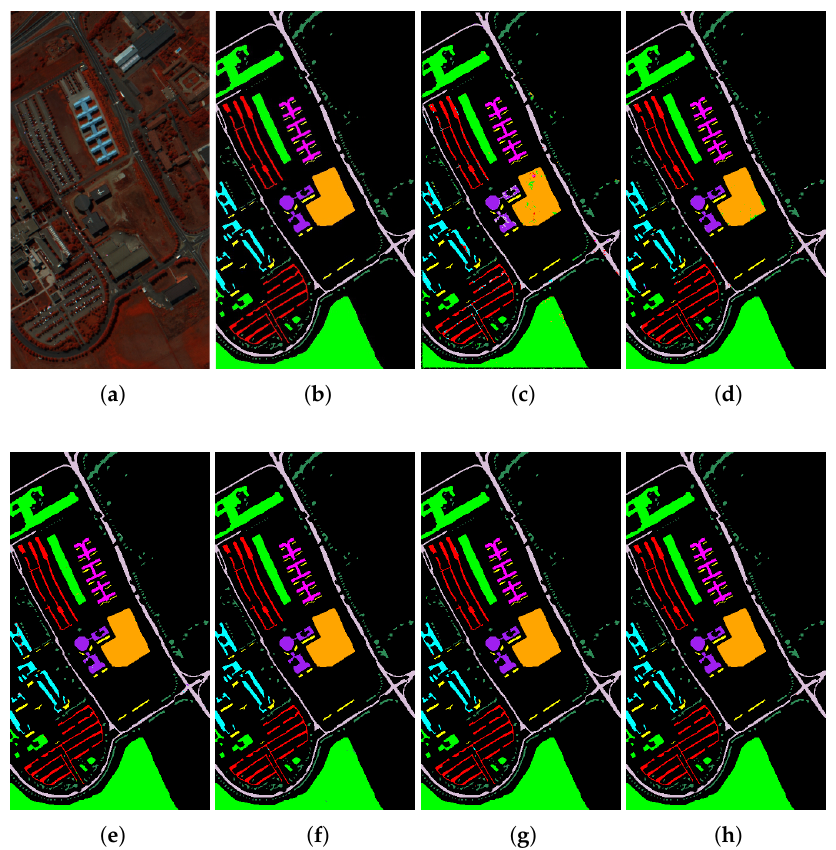
Figure 7. The classification map of Pavia University dataset. ( a ) False color image, ( b ) Ground truth, ( c – h ) Prediction classification maps of 3D-CNN (94.07%), SSLSTMs (98.50%), SSUN (99.52%), SSRN (99.88%), HybridSN (99.85%), and our proposed architecture (99.94%).